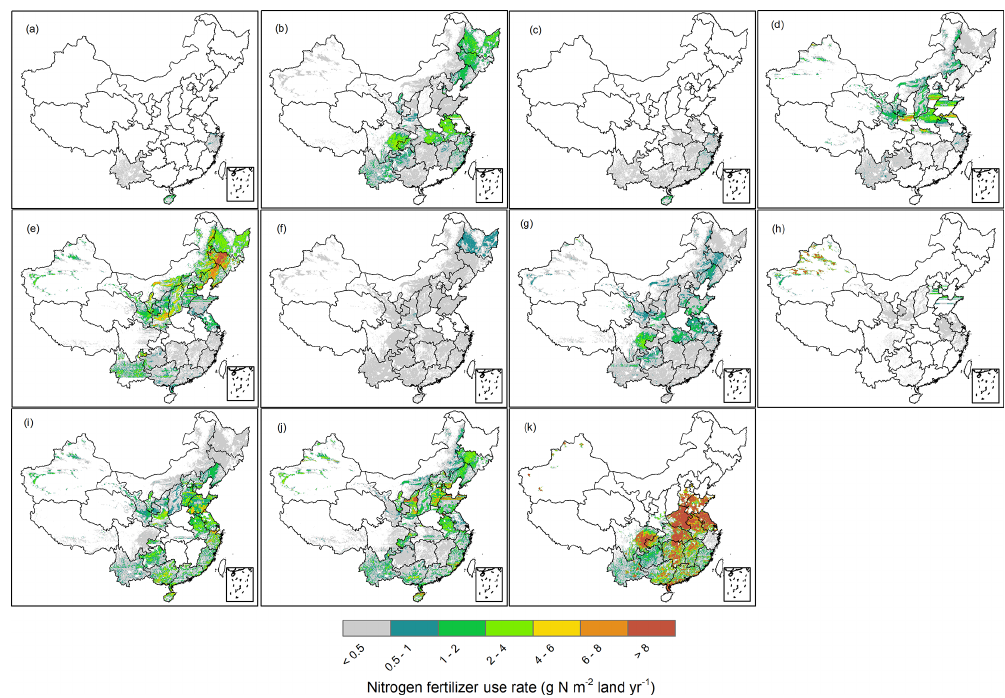
Figure 6. Spatial distribution of nitrogen fertilizer use rate by crop species in 2018. Panels (a) – (h) indicate the fertilizer use rate in early rice, mid-season rice, late rice, wheat, corn, soybean, oil seeds, cotton, vegetables, other crops, and double crops, respectively; the value in the scale bar indicates the N fertilizer use rate per square meter of